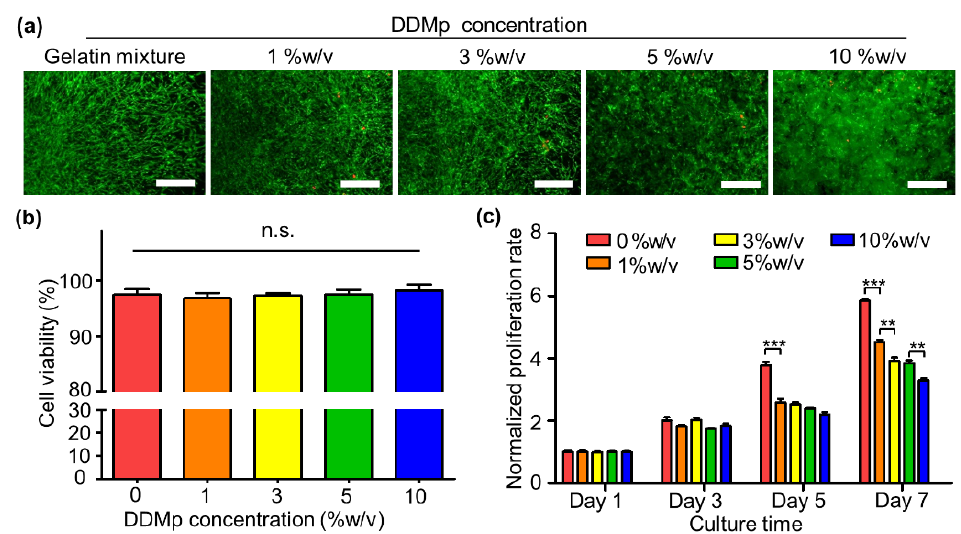
Figure 3. Cytocompatibility of DDMp bio-ink. Live/dead staining results ( a ) and quantified cell viabilities ( b ) of dental pulp stem cells (DPSCs) in DDMp bio-inks at Day 7 (scale bar: 200 μ m; n = 5); ( c ) proliferation rate of DPSCs in DDMp bio-inks for 7 days (** p < 0.01; *** p < 0.001, n = 4).